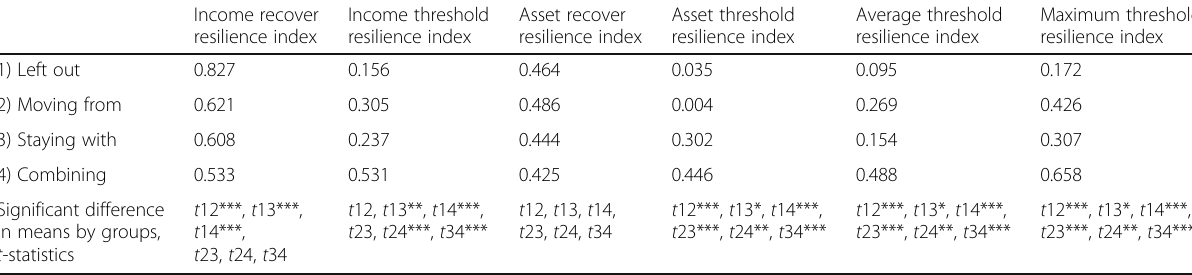
Table 11 Average resilience indices, by sub-group (1 is most resilient, 0 is least